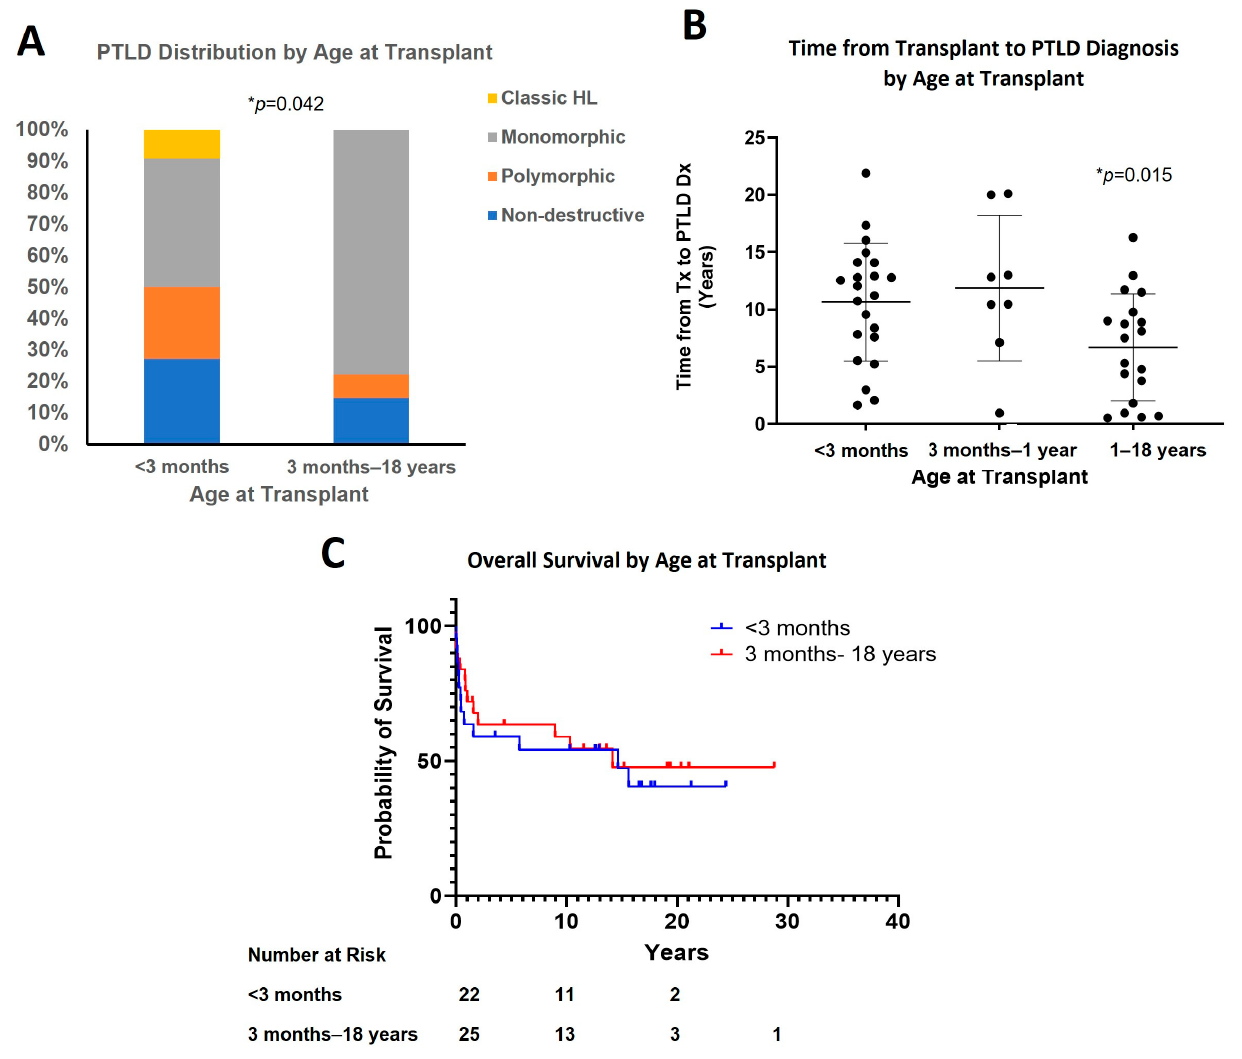
Figure 3. Effect of age at transplant. ( A ) PTLD distribution by age at transplant; ( B ) Time from transplant to PTLD diagnosis by age at transplant ( p = 0.015, <3 months vs. 1–18 years); ( C ) Overall survival by age at transplant.